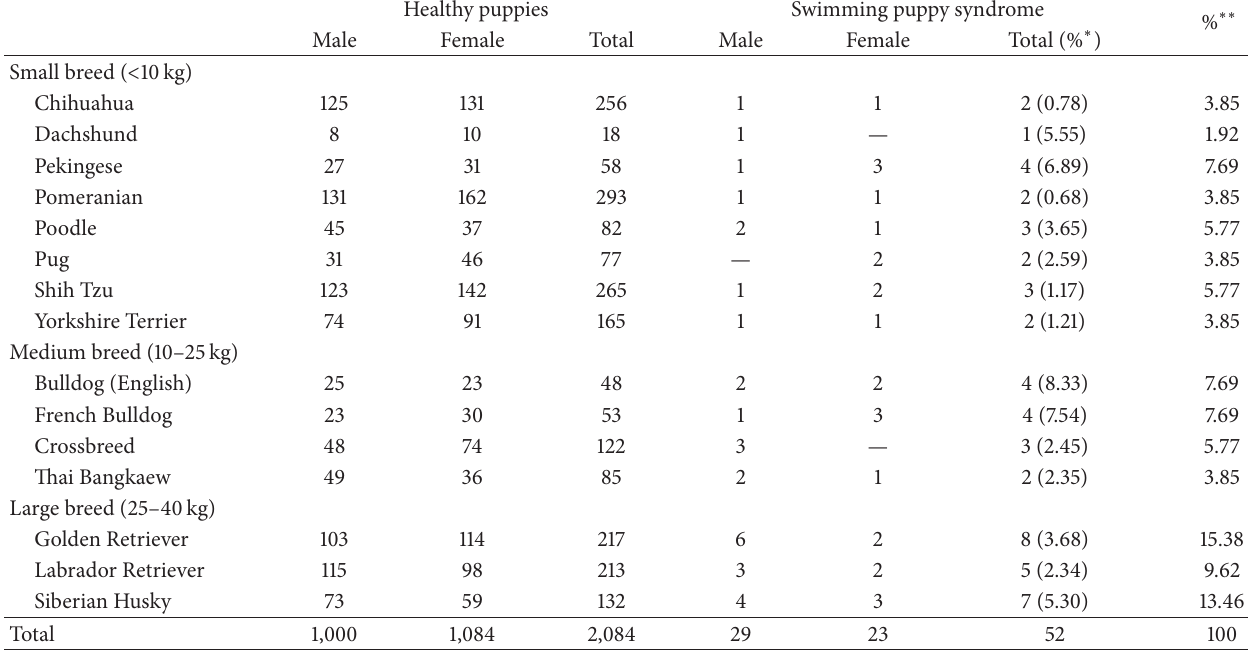
∗ Percentage of affected puppies compared within breeds. ∗∗ Percentage of affected puppies compared between breeds.